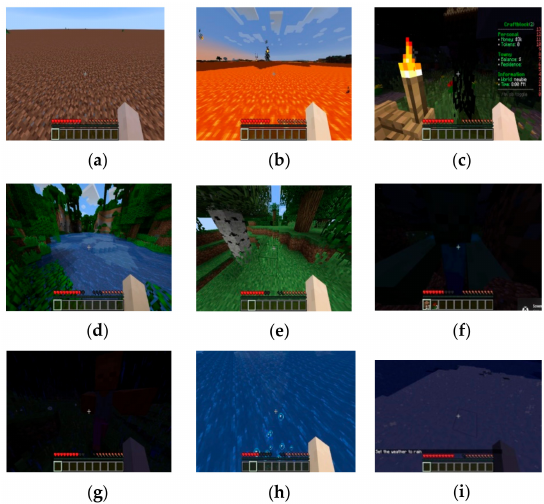
Figure 6. A sample of the testing images used to test the accuracy of the model in classifying new images. ( a ) Testing image for dirt class; ( b ) Testing image for fire class; ( c ) Testing image for grass and fire classes; ( d ) Testing image for grass and ocean class; ( e ) Testing image for grass class; ( f ) Testing image for mildew(zombie) class; ( g ) Testing image for mildew and grass classes; ( h ) Testing image for ocean class; ( i ) Testing image for snow.